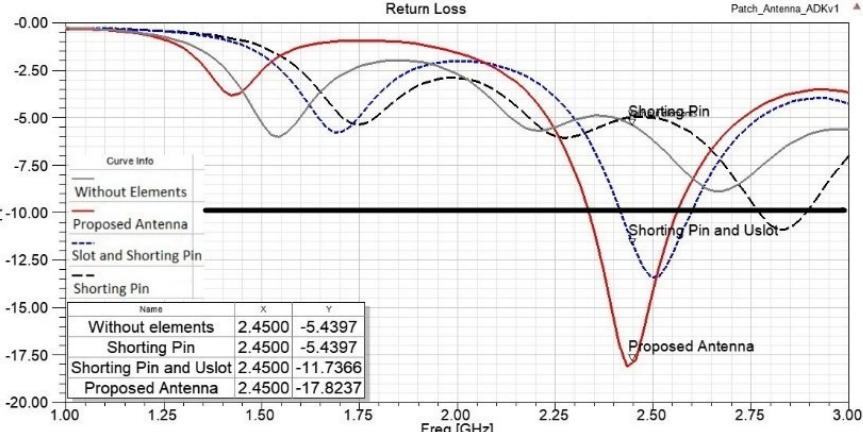
Figure 5. Reflection coefficient after antenna structure modifications in the ISM band in the pan-